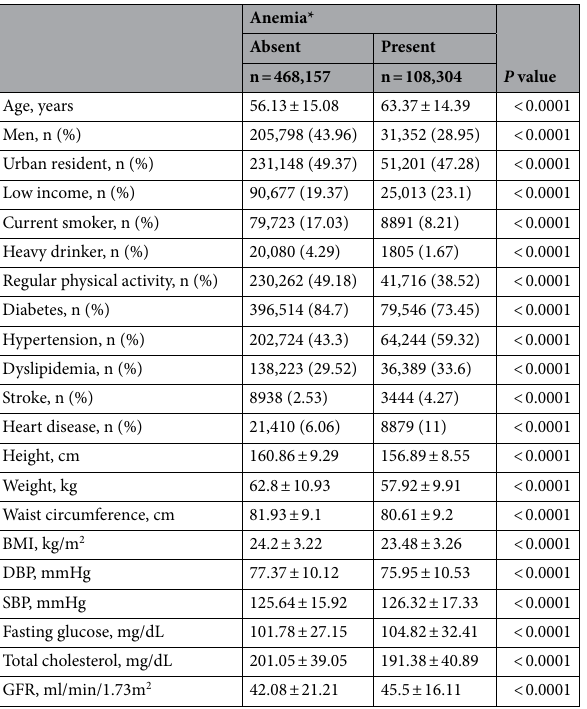
Table 1. Baseline characteristics of chronic kidney disease patients according to the presence of anemia. Data are presented as means ± standard deviations or numbers and percentages. BMI body mass index; DBP diastolic blood pressure; SBP systolic blood pressure; GFR glomerular filtration rate. *Anemia was defined as a hemoglobin level of < 13 g/dL in men and < 12 g/dL in